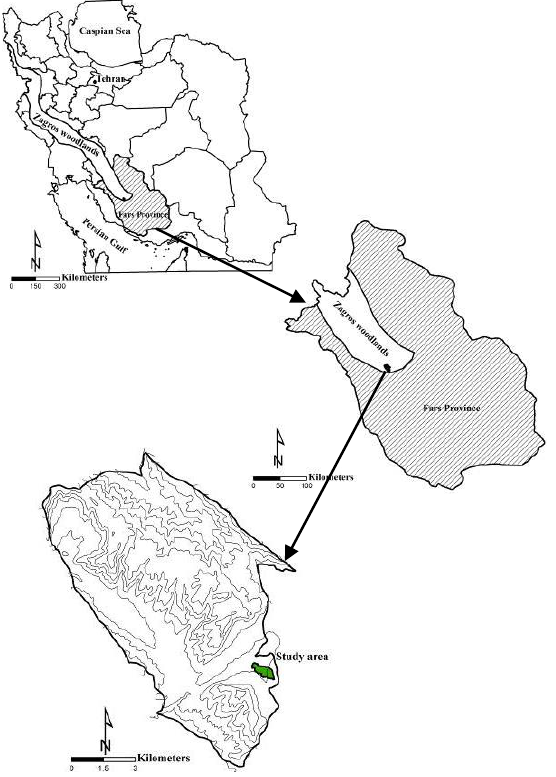
Figure 1. Map identifying the location of Fars province relative to Iran and the study